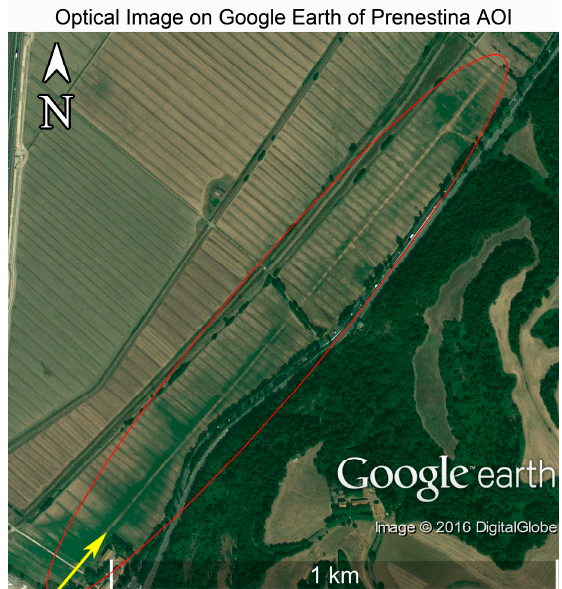
Figure 49. Optical image available on Google Earth, acquired on 11 September 2009. The ancient Via Salaria (highlighted by the red ellipse) is clearly visible as a negative crop mark with positive crop marks on either side along the southern part of the feature. Yellow arrow shows location and direction in which photo 6 was acquired (Figure 48). Courtesey of Google Earth.